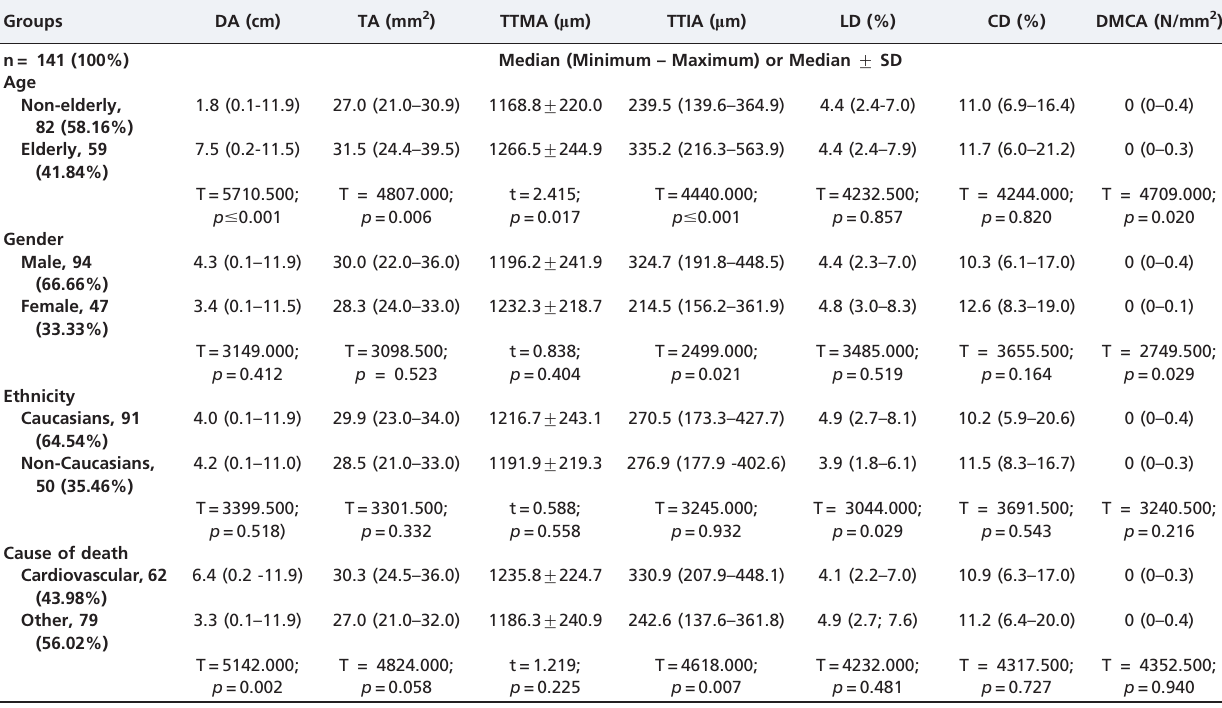
Table 1 - Morphometric analysis of aortas from autopsied patients. Groups